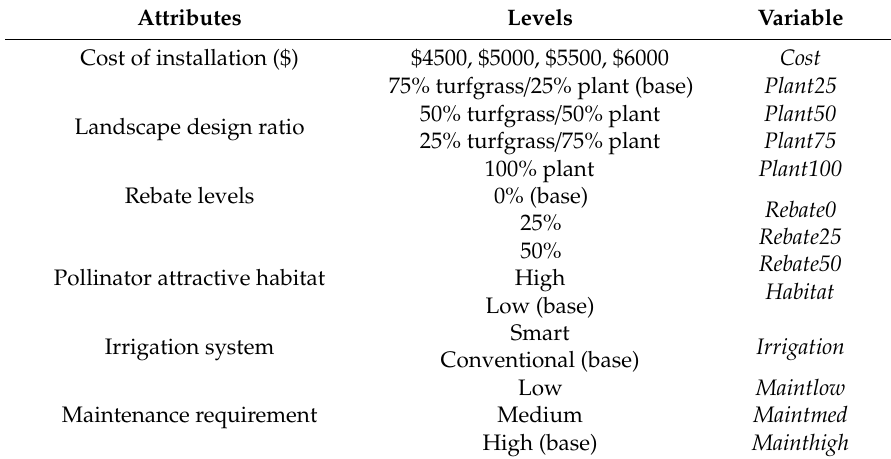
Table 1. Alternative low-input landscape attributes and attribute